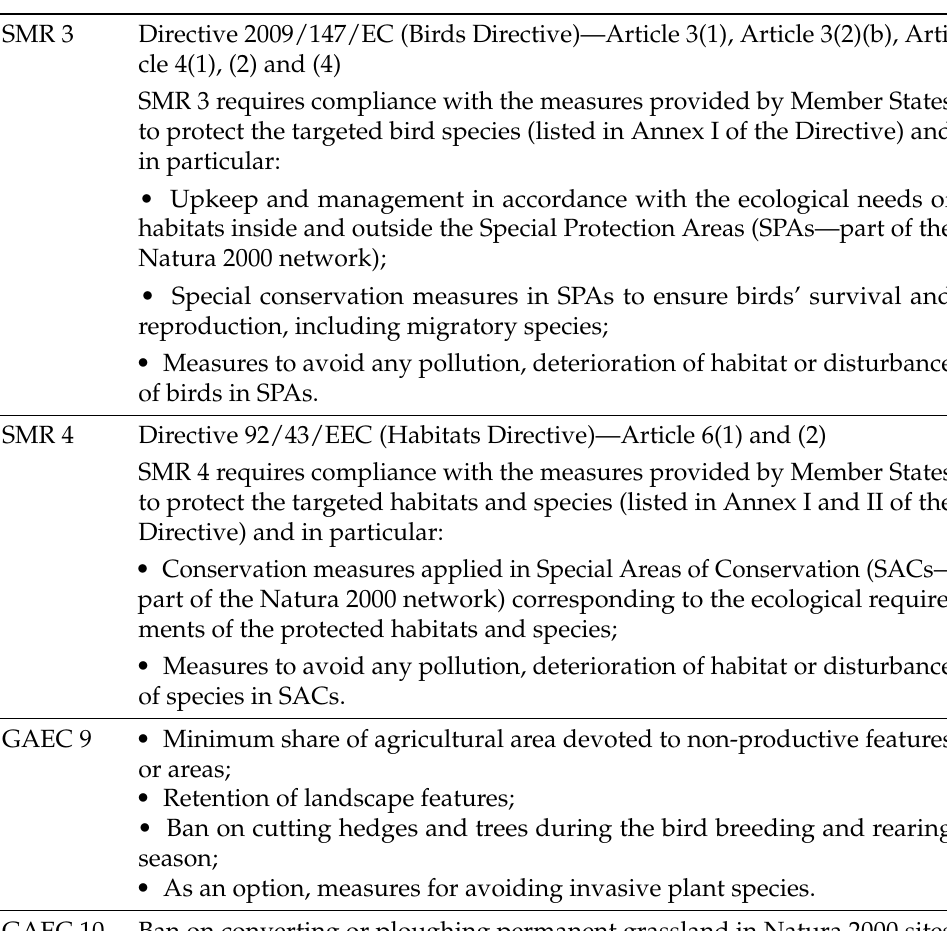
Table 1. Enhanced conditionality relevant for FAB—Adapted from Annex III, Commission